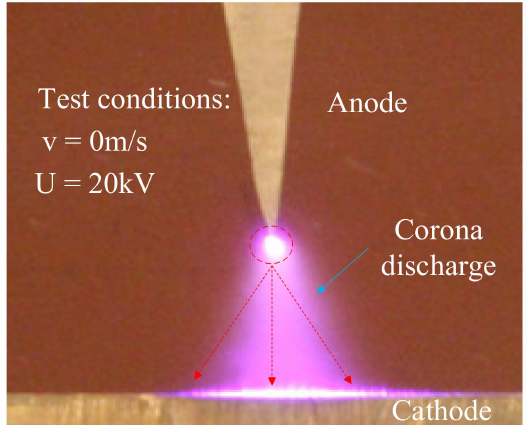
Figure 4. Image of corona discharge at an applied voltage of 20 kV without airflow.